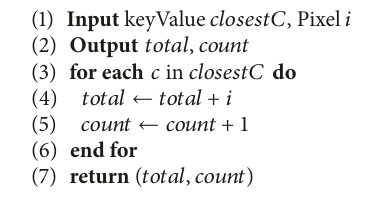
Algorithm 2: ReducebyKey segmentation function.